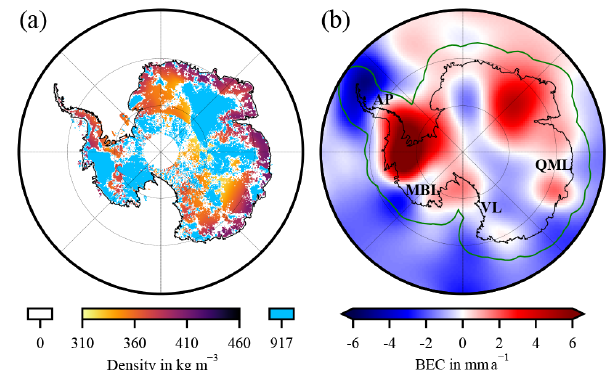
Figure 5. (a) Estimated ρ α density (Eq. 10) of the reference experi- ment. (b) GIA-induced bedrock elevation change (BEC) of the ref- erence experiment (rms: 2.2mma − 1 ); 400km buffer zone (green line); geographical regions indicated: Antarctic Peninsula (AP), Marie Byrd Land (MBL), Victoria Land (VL), and Queen Mary Land (QML). For results from the other simulation experiments see Figs. S4 and